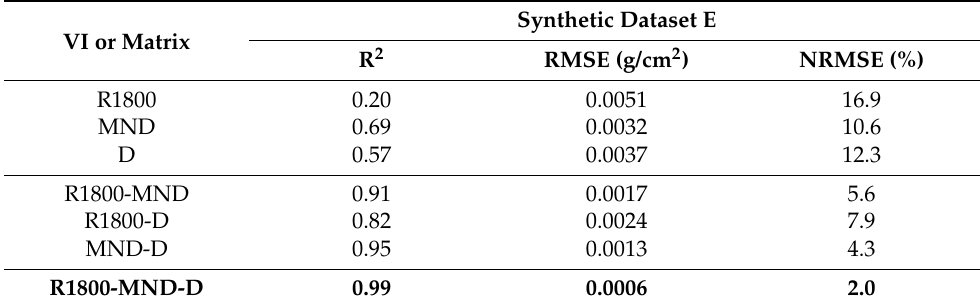
Table 5. Retrieval performances of LMA using R1800-MND-D, corresponding 2D matrices, and single VIs (the optimal results are indicated in